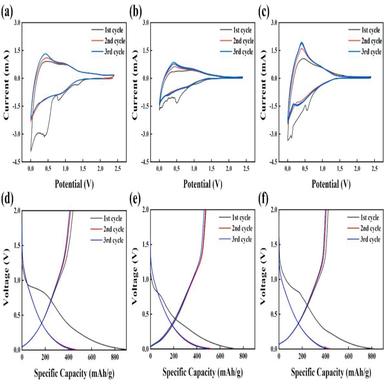
Cyclic voltammograms of (a) WM-SC; (b) WM-NC; and (c) WM-TOC, and charge/discharge profiles of (d) WM-SC; (e) WM-NC; and (f) WM-TOC.